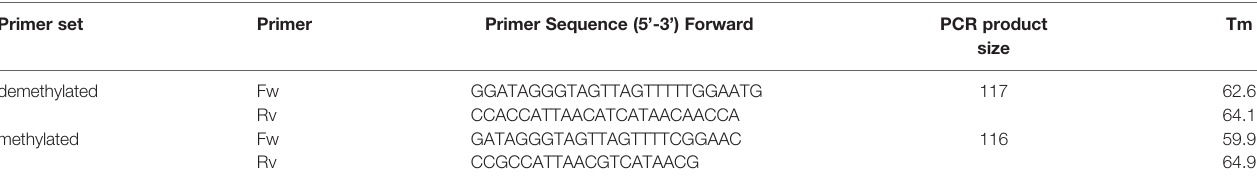
TABLE 3 | Primers for TSDR analysis